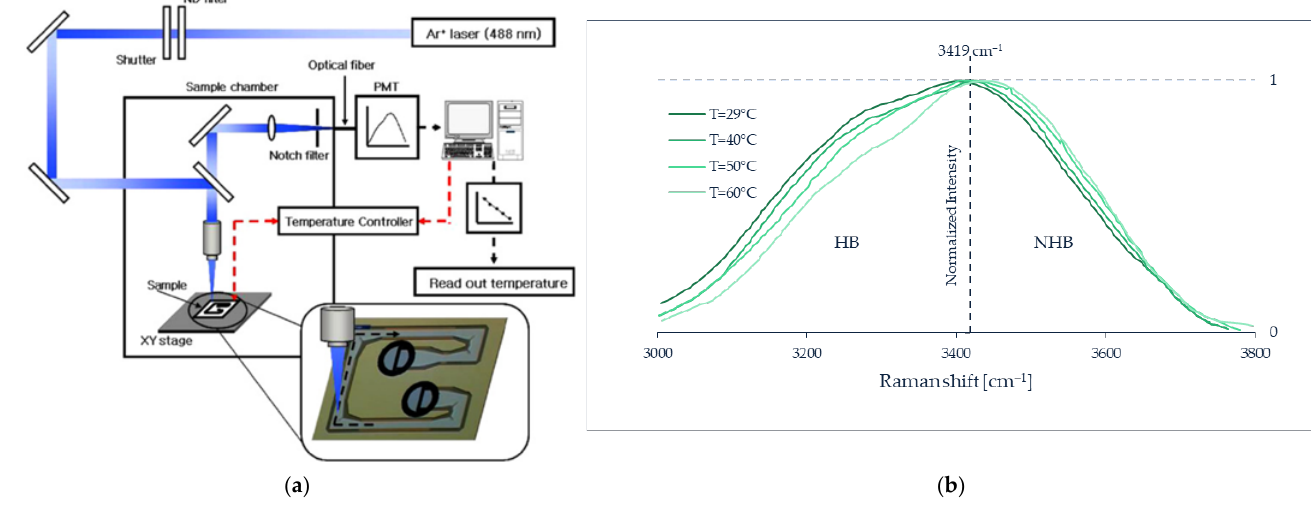
Figure 26. ( a ) Schematic diagram of the micro-Raman spectroscopy system used by Kim et al. Reprinted by permission from Ref. [142], Journal of Micromechanics and Microengineering, Copyright © 2022 IOP Publishing Ltd. ( b ) Changes in the OH stretching band of liquid water at different temperatures. Data from